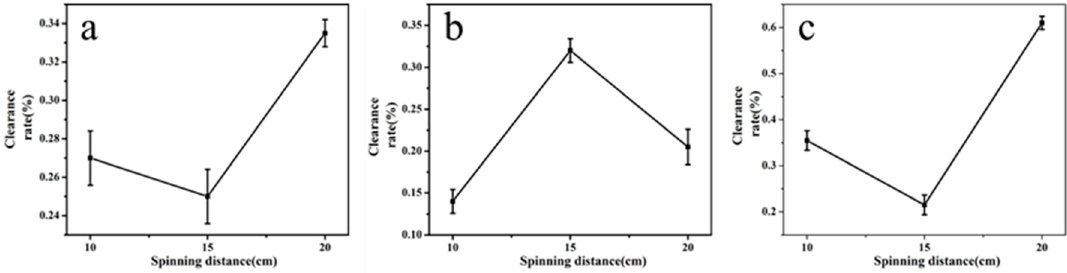
Figure 3. Impact of spinning distance on the clearance rate of active molecular membranes ( a : quercetin; b : glycyrrhizic; c : α -mangostin). Table 4. The impact of the spinning distance on the diameter of fiber.